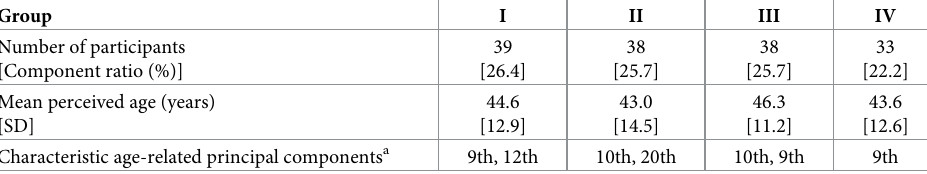
Table 2. Results from cluster analysis and characteristic age-related principal components (PCs) for each group. Group